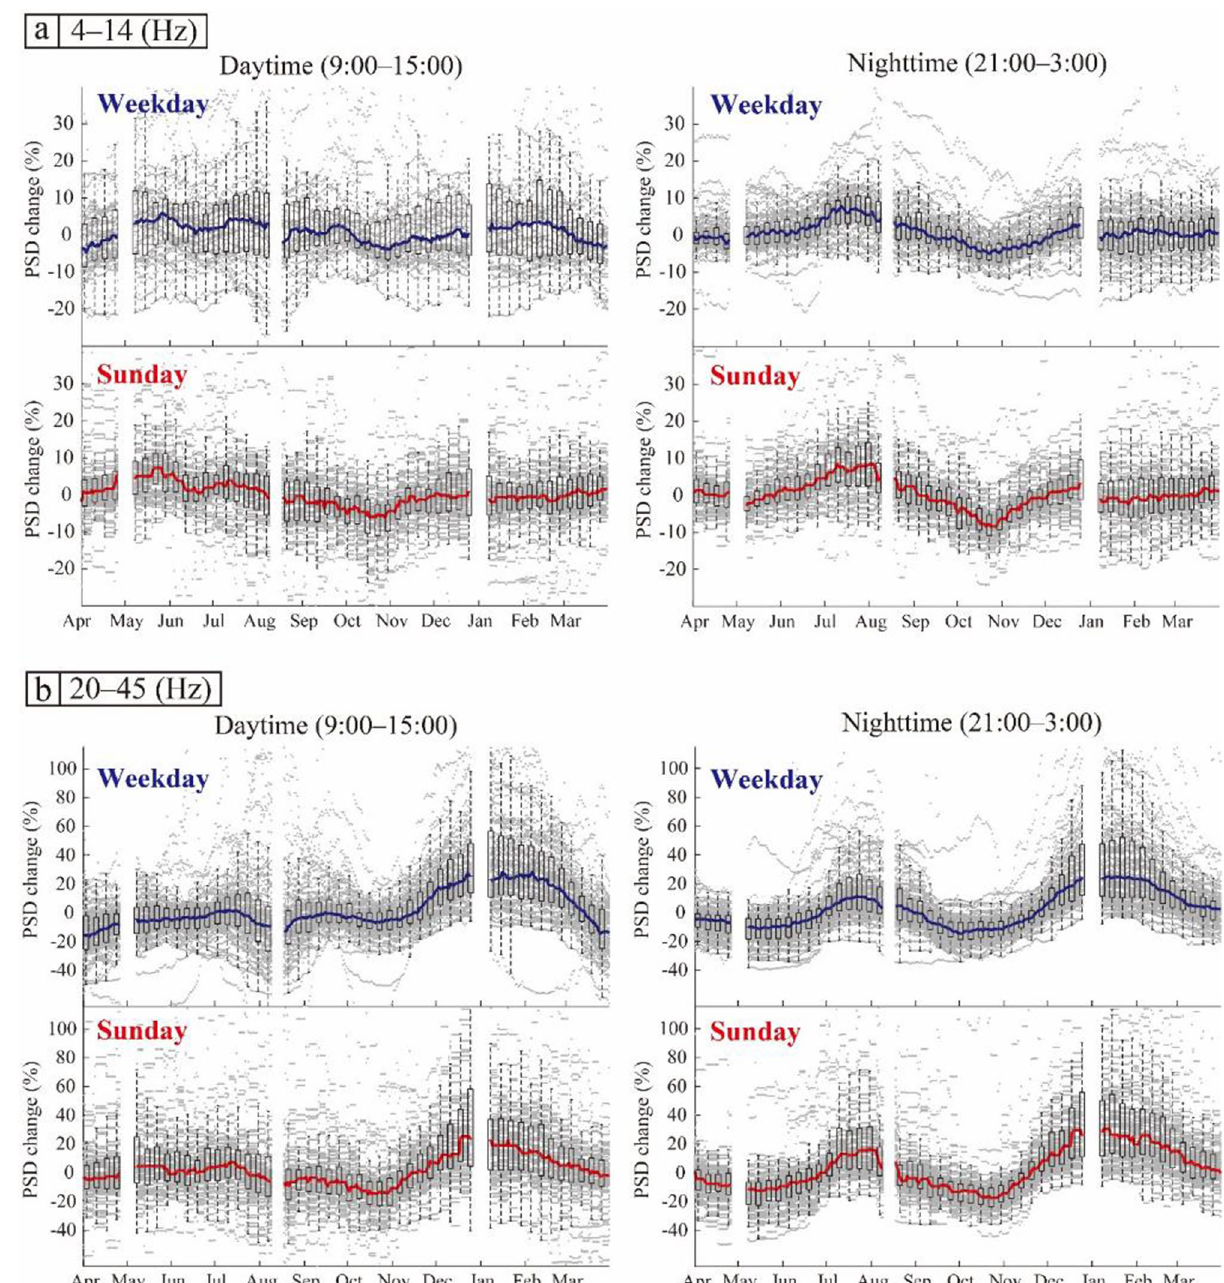
Figure 6. Seasonal variations in the relative noise level in the frequency range ( a ) 4–14 Hz and ( b ) 20–45 Hz. Left and right panels show the result of daytime and nighttime, respectively. Gray dots represent the seasonal variations at each station which show correlation coefficients > 0.2 (circles in Fig. 2b,c). The blue and red solid lines indicate the median values on weekdays and Sunday, respectively. The boxes represent the first and third quartiles and the error bars represent the minimum and maximum values within the ×1.5 the interquartile range from the first and third quartiles. The boxes and error bars were plotted for every 7 a reduction (light blue and orange lines in Fig. 8c). Moreover, the results for the time of day in this range also showed only a small reduction in the first state of emergency (gray and right orange lines in Fig. 3b). The first state of emergency was less sensitive to the noise level at night (21:00–3:00). In addition, the daytime PSD on weekdays in the high-frequency range further decreased after the beginning of the school closures, but the decrease was smaller (blue line in Fig. 8c). During the first state of emergency, in addition to the school closures, the majority of educational and recreational facilities were ordered to close; therefore, noise decreased more significantly during this period than during the school closure period. The daytime results for weekdays during the first state of emergency were similar to the two-step PSD reduction